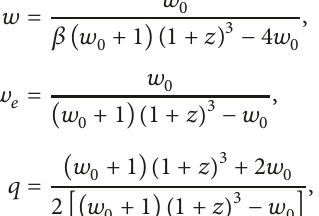
Figure 3: 𝑤 has been depicted versus 𝑧 for some values of 𝛽 .